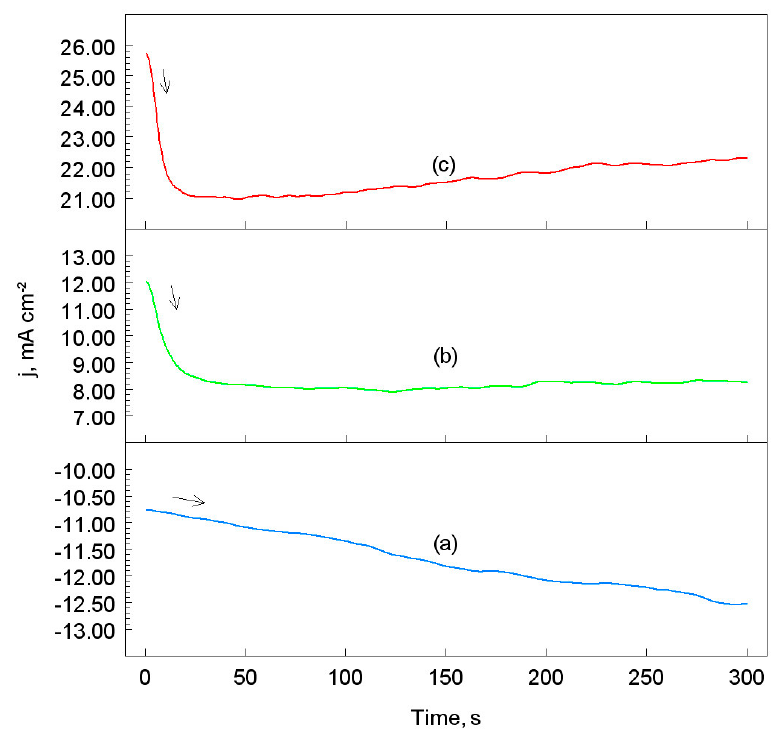
Figure9. Chronoamperometriccurvesof M28 nickelcoatingobtainedfor: ( a ) − 650, ( b )10, and( c )150mV. The solution contained 1.2 M Cl − , pH